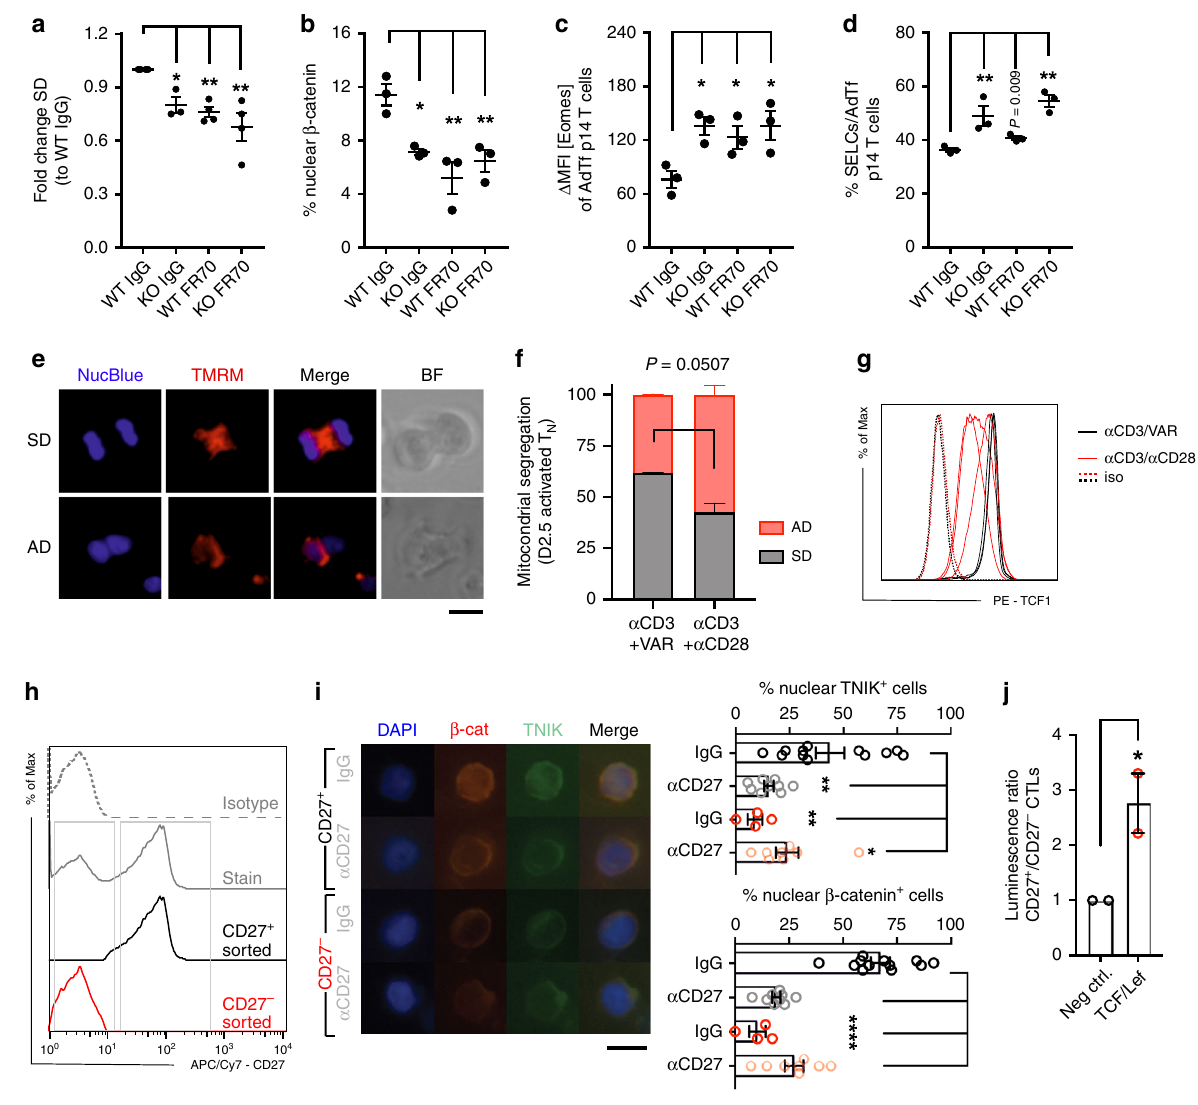
Fig. 7 TNIK is a CD27 downstream adaptor molecule and regulates Wnt signaling. a ImageStream X analysis of Numb segregation in mitotic WT and KO p14 T cells after 48 h of co-culture with H8-DCs in the presence of 20 μ g ml − 1 blocking FR70 Ab or IgG (175 – 333 mitotic cells). Numb segregation per culture replicate was analyzed, and frequencies of asymmetric division (AD) vs symmetric division (SD) were assessed. Fold change of SD normalized to WT IgG control is depicted. Pooled data from two independent experiments (1 – 2 replicates per timepoint). b – d In total, 10 5 Cd45.1 + Tnik WT (WT) or Tnik − / − (KO) p14 T cells from the spleen were AdTf into naive Cd45.2 + mice previous to infection with 10 4 pfu LCMV-WE. Mice were injected i.p. with 300 μ g FR70 mAb or IgG on days − 1/ + 2/ + 5. b – d Analysis day 6 p.i. ( n = 3 mice per group). b FACS-sorted p14 T cells stained for β -catenin. Dotplot shows frequency of nuclear localization analyzed by ImageStream X. c Δ MFI of Eomes and d frequency of KLRG1 + CD127 − p14 SLECs (spleen). e , f Live imaging of dividing α CD3/VAR ( n = 183) or α CD3 α CD28 ( n = 170) in vitro-activated human naive CD8 + T cells (T N ) (two donors, two independent experiments): nucleus (NucBlue) and mitochondira (TMRM) stain, merge and brigh fi eld (BF) of representative mitotic cells; scale bar 10 μ m. Frequency of AD vs SD of total ( n = 170-182) dividing cells is shown. g Histogram showing TCF-1 expression of α CD3/VAR (black lines) or α CD3 α CD28 (red lines) activated T N cells and isotype controls (iso; dashed lines). h Histogram showing CD27 expression (gray solid line), isotype control (gray dotted line), puri fi ed CD27 + (black line), and CD27 − (red line) HIV gag-speci fi c human CD8 + T cell clone. i CD27 + (black/gray dots) and CD27 − (red/light red dots) T cells cultured under 0.3 μ g ml − 1 OKT3 and 10 μ g ml − 1 CD27 blocking mAb or IgG. Percentage of cells positive for nuclear TNIK or β -catenin is depicted (three independent experiments; 4 – 12 replicates; 60 – 79 cells per replicate); scale bar 10 μ m. j TCF/LEF lentiviral reporter assay: luminescence ratio (CD27 + /CD27 − ) relative to negative control lentiviral particles. h , i Representative results of two independent experiments depicted. Data displayed as means ± SEM. Statistics: a – d , i one-way ANOVA, f , j two-tailed Student's t test, nonsigni fi cant P > 0.05, * P < 0.05, ** P < 0.01, **** P < 0.0001. Source data are provided as a Source Data fi